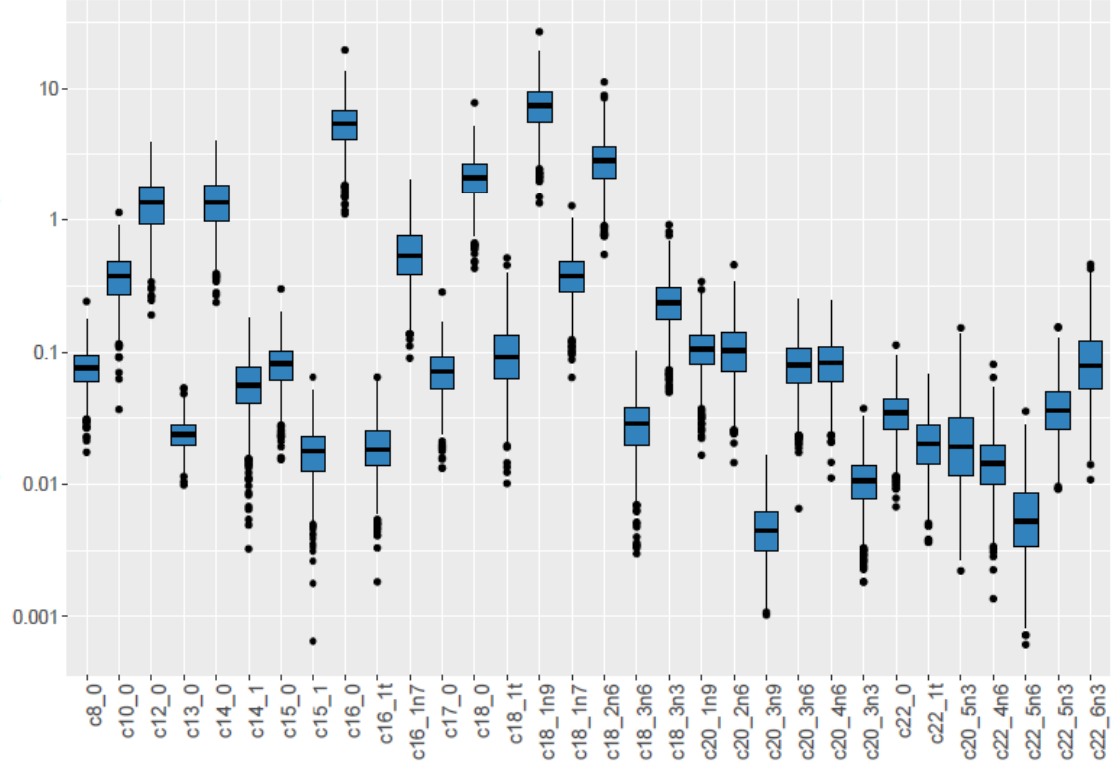
Figure 2. Boxplot of TGFA concentrations in study population ( n = 789) 1 . Legend: 1 X-axis represents TGFAs measured in milk samples. Y-axis represents log 10 of breast milk concentration.